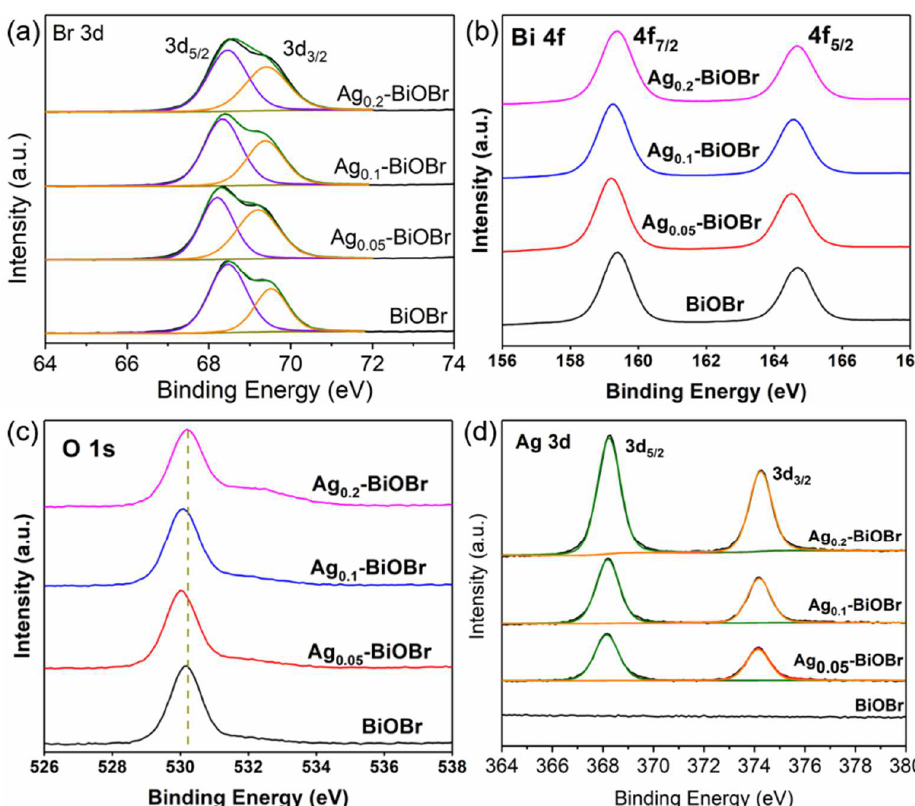
Figure 3. ( a ) Br 3d, ( b ) Bi 4f, ( c ) O 1s and ( d ) Ag 3d of BiOBr and Ag-BiOBr.